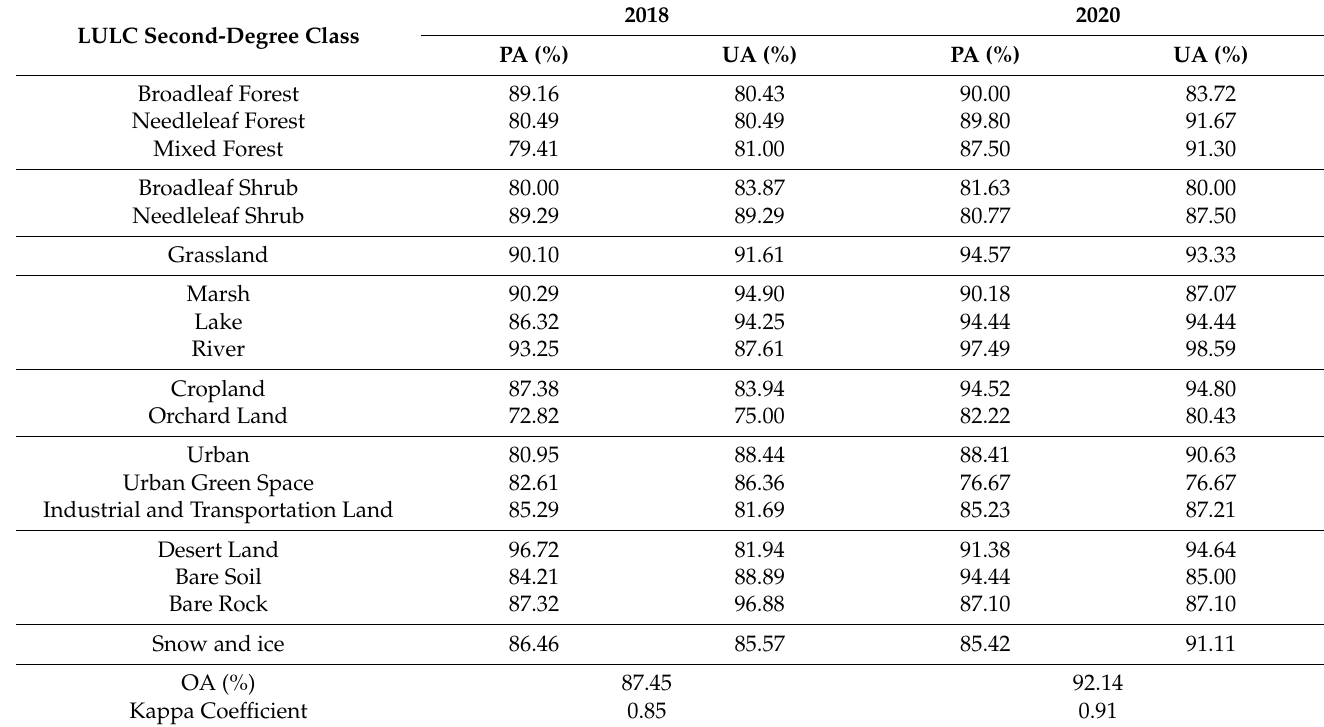
Table 5. The confusion matrix of LULC second-degree class accuracy (PA: producer’s accuracy; UA: user’s accuracy; OA: overall